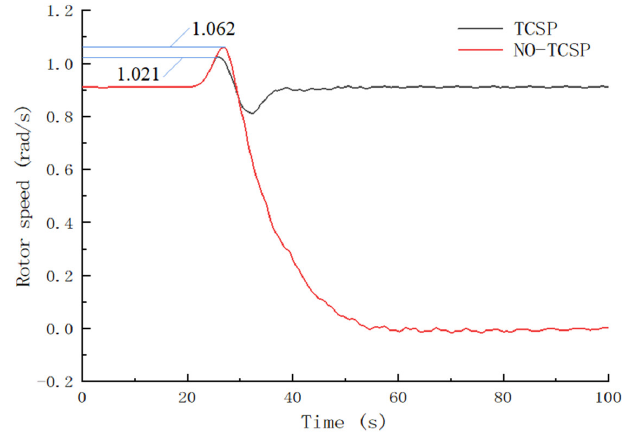
Figure 5. Rotor speed comparison.